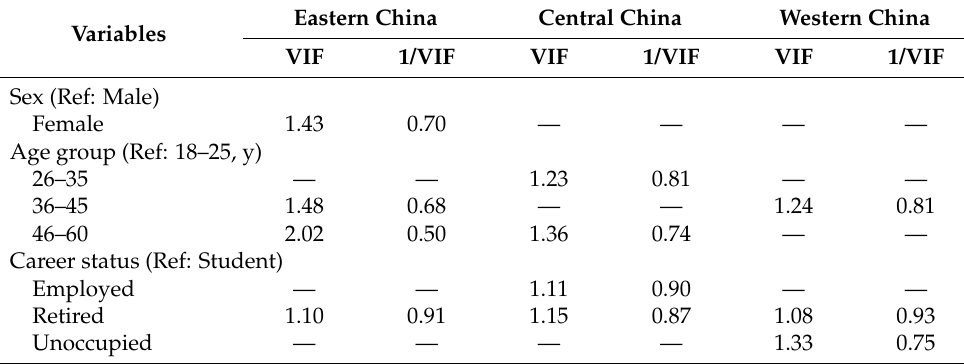
Table A8. The variance inflation factor of variables in stepwise regression analysis stratified by